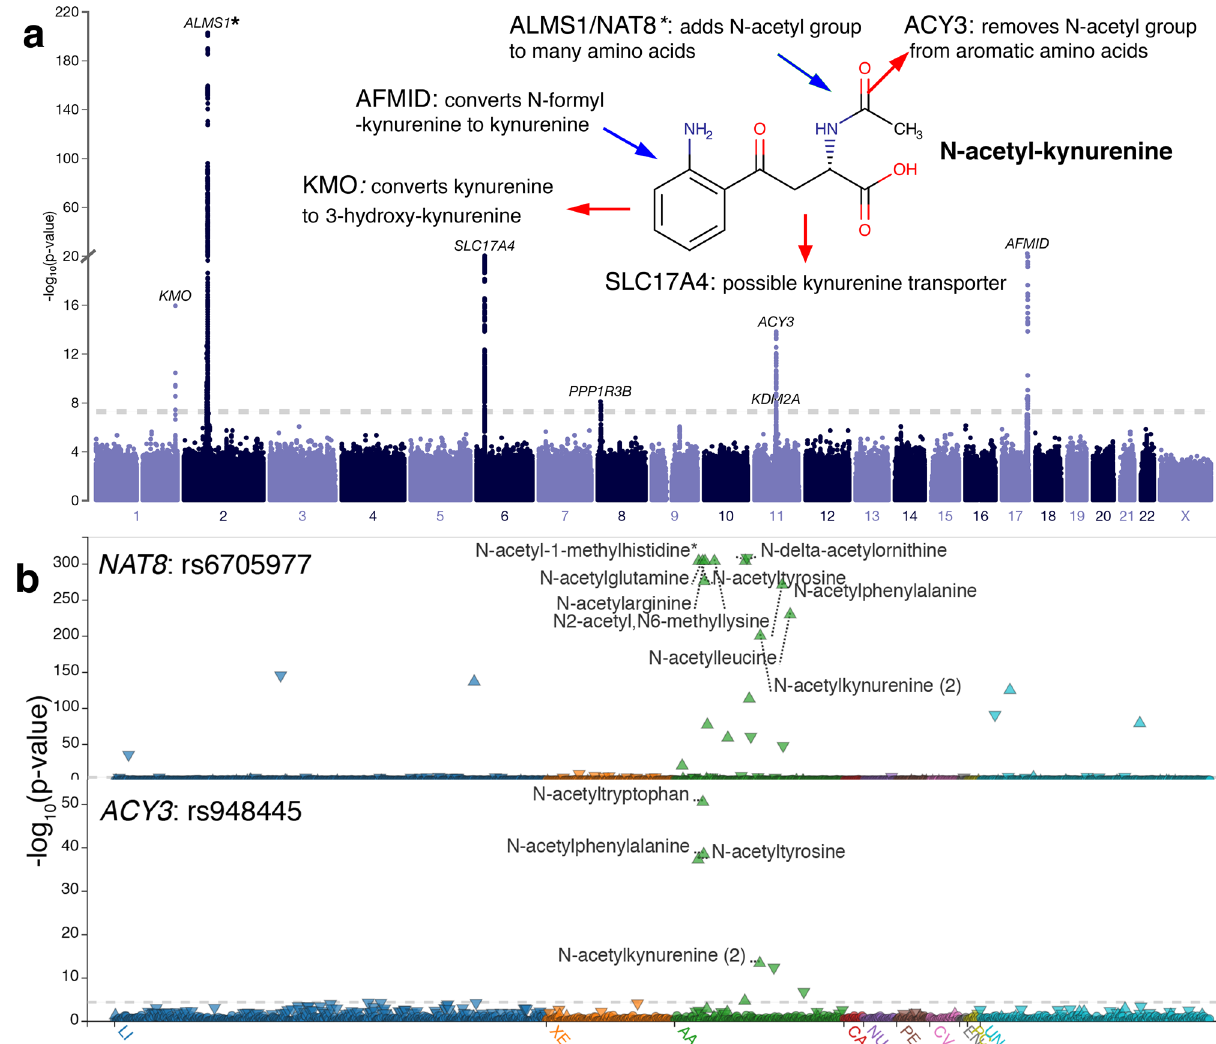
Fig. 2 Our METSIM Metabolomics PheWeb facilitates the characterization of genetic associations and gene activities. a Manhattan plot for N-acetylkynurenine highlights the roles of the associated genes (https://pheweb.org/metsim-metab/pheno/C100006378). Chemical structure for N-acetylkynurenine (in bold face) and activities for the associated genes are added manually on top of the Manhattan plot. b Stacked PheWeb plots show signi fi cant associations between rs6705977 ( NAT8 , https://pheweb.org/metsim-metab/variant/2:73622043-C-G) and fi fteen N-acetylated molecules, and the more restricted set of associations between rs948445 ( ACY3 , https://pheweb.org/metsim-metab/variant/11:67647021-C-T) and four N-acetylated aromatic amino acids. LI: lipid; XE: xenobiotics; AA: amino acid; CA: carbohydrate; NU: nucleotide; PE: peptide; CV: cofactor and vitamin; EN: energy; PC: partially characterized; UN: